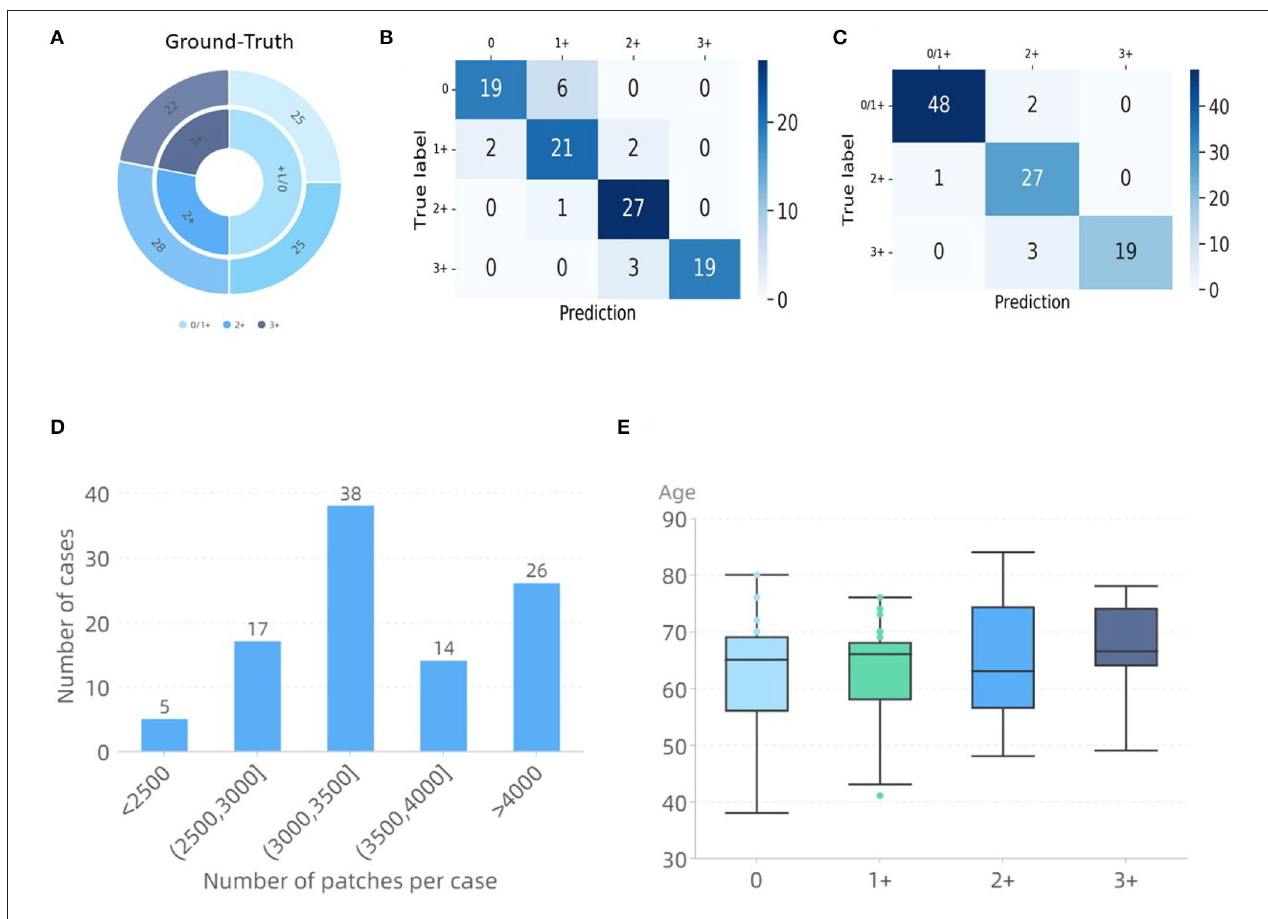
FIGURE 7 | WHSPN dataset validation results. (A) Ground-Truth. (B) Confusion matrix diagram of four classes. (C) Confusion matrix diagram of three classes. (D) Distribution of the number of tiles per case. (E) Ages distribution of the cases used in this